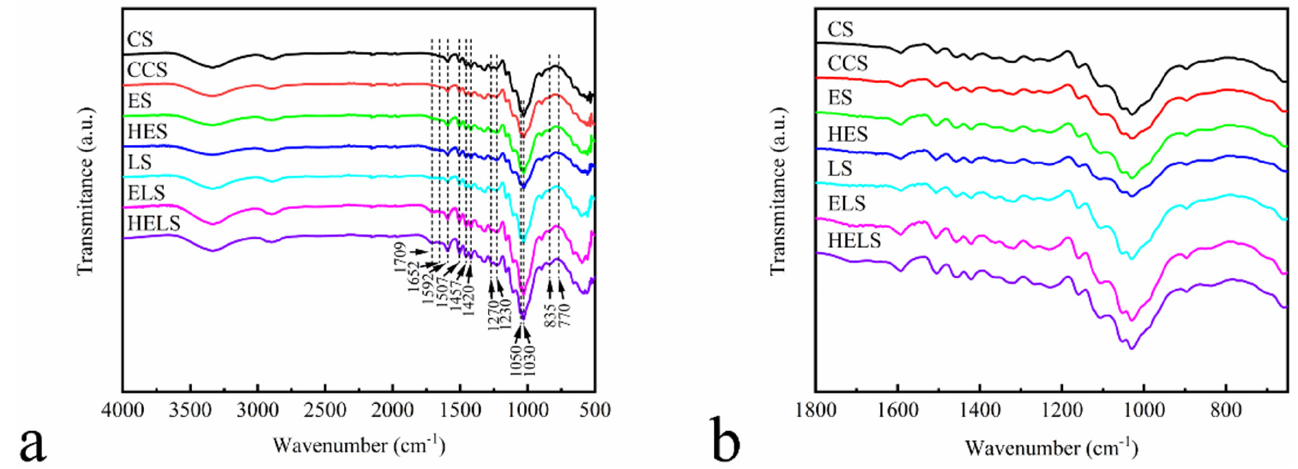
Figure 7. Fourier transform infrared (FTIR) analyses of MFP in the 4000–500 cm − 1 range: ( a ) Full FTIR spectrogram; ( b ) FTIR spectrogram between 1800 and 650 cm − 1 .